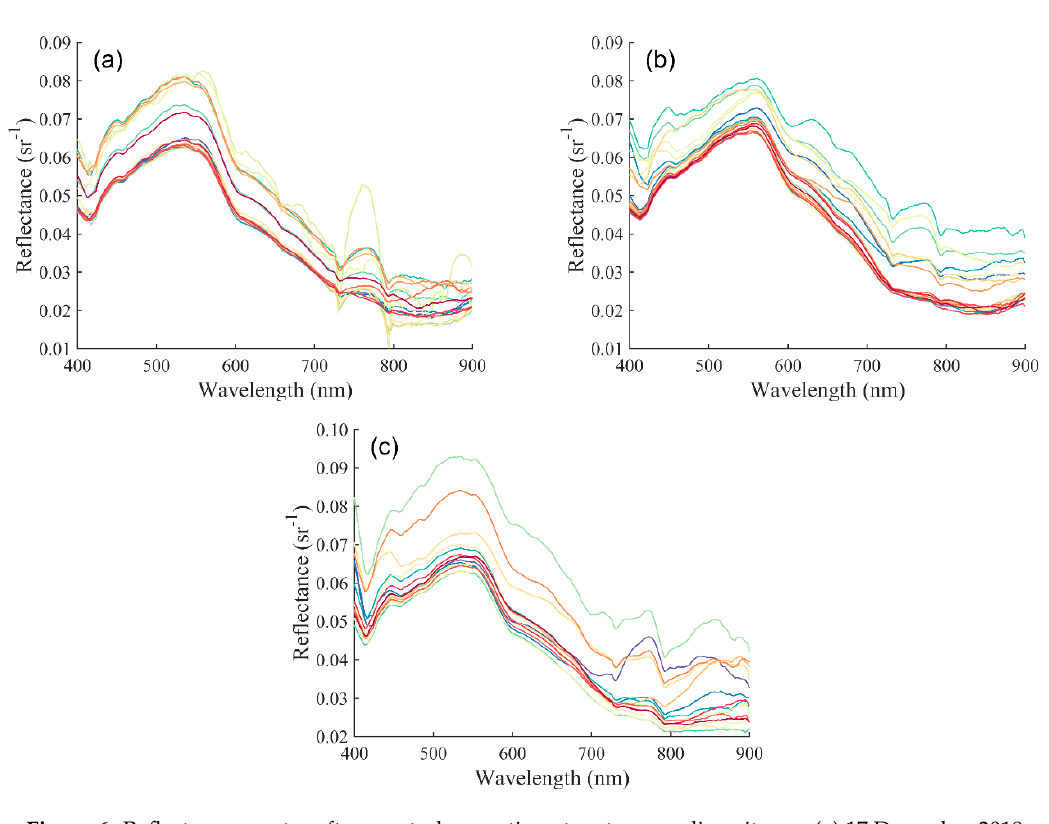
Figure 6. Reflectance spectra after spectral correction at water sampling sites on ( a ) 17 December 2018, ( b ) 22 March 2019, and ( c ) 20 July 2019.